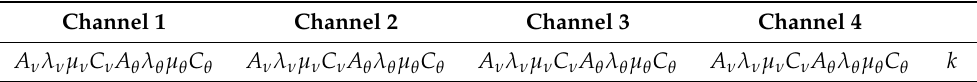
Table 1. Structure of a chromosome.